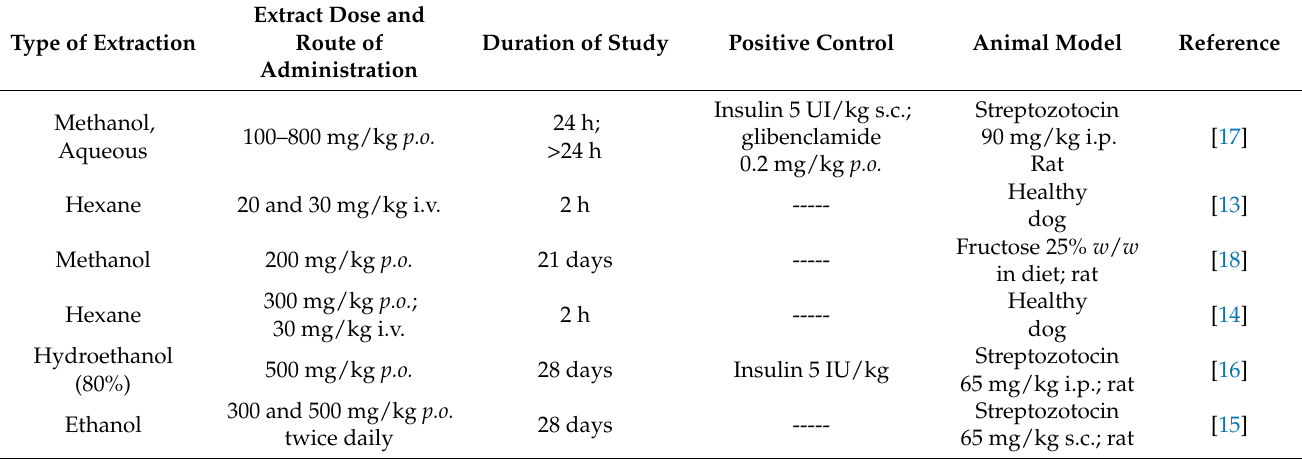
Table 1. A. occidentale stem bark hypoglycemic activity in vivo